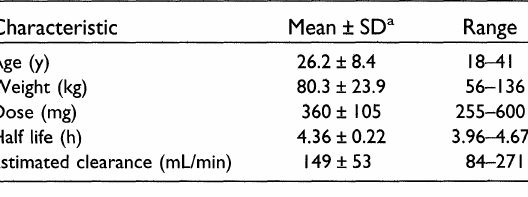
TABLE !. Demographic and pharmacokinetic